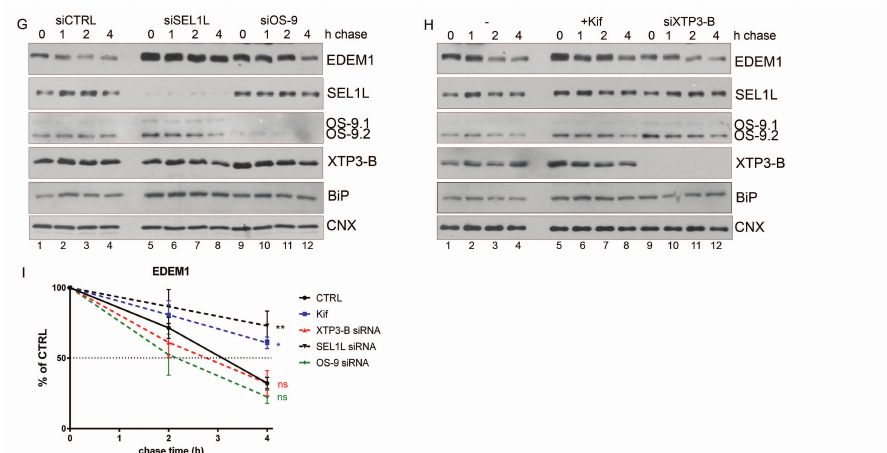
Figure 1. EDEM1 (ER-degradation enhancing α -mannosidase-like) turnover is modulated by ERAD (endoplasmic reticulum-associated protein degradation) proteins. ( A ) Volcano plot of proteins identified using mass spectrometry after enrichment with anti-EDEM1 antibodies from HEK293T cells overexpressing an empty vector (CTRL) or EDEM1 lysed in Triton-X100-containing bu ff er. Peptides were identified for three biological replicates, assembled in protein groups using MaxQuant, and the label-free quantification (LFQ) values were exported for further analysis. A t -test with permutation-based FDR correction was applied to select the statistically significant proteins. Black points represent background proteins, and light green represent significant proteins. EDEM1 is represented in black and bold text. The dash line indicates the threshold for statistically significant proteins ( p < 0.05 and a minimum log t -test di ff erence of 4 was considered). ( B ): All the identified proteins were annotated with Gene Ontologies (GO) biological processes terms from UniProt database, and only entries that contained the ERAD (upper panel) and protein folding (lower panel) key terms were further kept for analysis. The colour key denotes the mean of biological triplicates after the log transformation of the intensity / LFQ values. ( C,D ): HEK293T cells overexpressing EDEM1 treated or not with kifunensine were lysed in a Triton-X100-containing bu ff er and cleared lysates were subjected to separation on a 10–40% sucrose gradient. Equal volumes of sucrose gradient fractions that were TCA-precipitated and resuspended in 4% SDS bu ff er, treated ( D ) or not ( C ) with kifunensine were separated in reducing conditions by SDS-PAGE, transferred onto nitrocellulose membranes, and probed with the indicated antibodies: HA (for detecting EDEM1 glycosylated (g) and non-glycosylated (ng) forms), SEL1L, calnexin (CNX), OS-9 (for detecting OS-9.1 and OS-9.2), XTP3-B, HRD1, and GAPDH. ( E ): HEK293T cells were transfected with siRNAs targeting a non-specific sequence (CTRL), alongside siRNA for SEL1L, OS-9, XTP3-B, and HRD1 for 72 h. Cells were harvested, lysed in Triton-X100-containing bu ff er and processed for SDS-PAGE in denaturing conditions; the proteins were transferred onto nitrocellulose membranes and probed with antibodies for EDEM1, SEL1L, OS-9 (detecting OS9.1 and OS9.2), XTP3-B, HRD1, and CNX as internal control. ( F ): Band densitometry of images present in ( E ) are represented as mean of 3 independent experiments ( n = 3 ± SEM) and one-way ANOVA comparison with Bonferroni correction was applied for statistical analysis (* p < 0.05, ** p < 0.01, *** p < 0.001, and **** p < 0.001). For simplicity of representation, only statistically significant samples are indicated. ( G and H ): HEK293T cells were transfected with siRNA targeting a non-specific sequence (CTRL), or siRNA-targeting SEL1L, OS-9, and XTP3-B for 72 h and treated or not (-) with kifunensine (kif) (30 µ M / ON); 48 h post transfection cells corresponding to each condition were divided in 4 individual dishes and incubated for another 24 h. Next, the medium was changed with fresh medium supplemented with 50 uM cycloheximide and harvested at the indicated time points. Cells were lysed in Triton-X100-containing bu ff er, and an equal amount of protein from each sample was prepared for SDS-PAGE in reducing conditions. The levels of endogenously expressed EDEM1, alongside SEL1L, OS-9, XTP3-B, BiP, and calnexin (CNX) were assessed by Western blotting. ( G ): The control (siCTRL), SEL1L (siSEL1L) and OS-9 (siOS-9) siRNA transfected samples. ( H ): Control (-), kifunensine ( + kif) and XTP3-B (siXTP3-B) siRNA treated cells. ( I ): Densitometry plot of EDEM1 bands from ( G ) and ( H ), represented as mean of 3 independent experiments ( n = 3 ± SEM), and one-way ANOVA comparison with Bonferroni correction was applied for statistical analysis (* p < 0.05, ** p < 0.01, *** p < 0.001, and **** p <